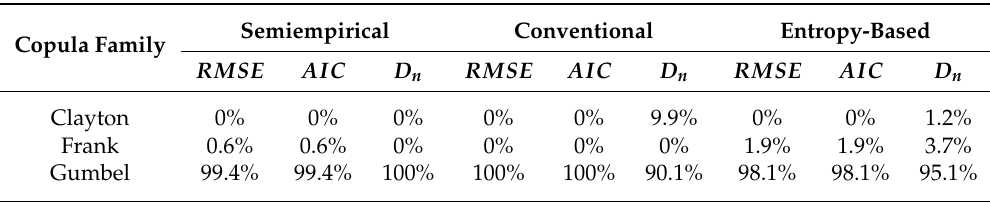
Figure 7. The fitted Archimedean copula versus the empirical copula for Changchun (station No. 54161) and Maerkang (station No. 56172): ( a ) semiempirical copula for Changchun; ( b ) conventional copula for Changchun; ( c ) entropy-based copula for Changchun; ( d – f ) with same meaning as in subfigures ( a – c ) but for Maerkang. Table 3. Percentages of stations in selecting optimal copula function based on RMSE , AIC , and KS D n